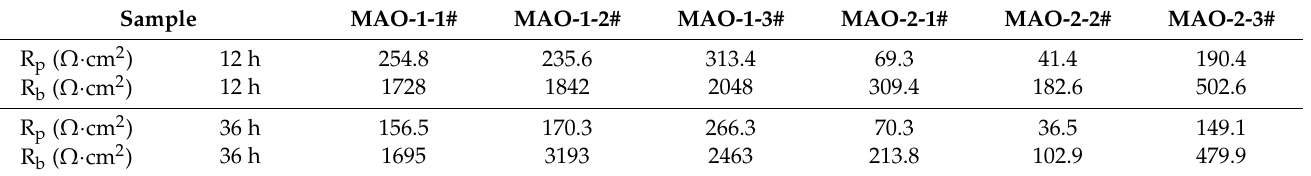
Table 1. The Fitting resistance values of EIS data of MAO specimens measured after 12 and 36 h immersion in 3.5% NaCl solution, respectively.